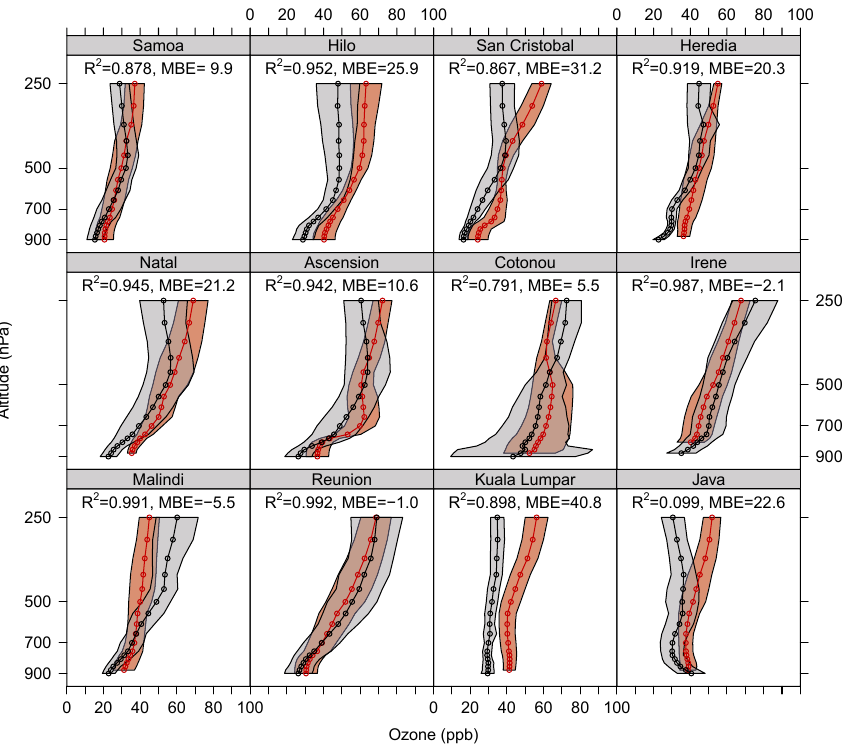
Fig. 3. Five-year mean O 3 (ppb) from the BASE run (red) compared to O 3 sonde data from the SHADOZ Network (Thompson et al., 2003) (ppb) from the BASE run (red) compared to O sonde data from the Fig. 3. Five year mean O 3 3 (black). Polygons show extent of monthly variability. Correlation coefficients ( R 2 ) are calculated using the Pearson method. Mean bias errors (ppb) from the BASE run (red) compared to O sonde data from the Fig. 3. Five year mean O SHADOZ Network (Thompson et al., 2003) (black). Polygons show extent of monthly variability. 3 3 (MBE) are in %; positive values indicate the model is biased high with respect to the measurement data. Correlation coe ffi cients ( R 2 ) are calculated using the Pearson method. Mean bias errors (MBE) SHADOZ Network (Thompson et˜al., 2003) (black). Polygons show extent of monthly variability. are in %; positive values indicate the model is biased high with respect to the measurement Correlation coefficients (R 2 ) are calculated using the Pearson method. Mean bias errors (MBE) Table 2. Changes in the O x budget (Tgyr − 1 ) from the present-day BASE integration caused by the change in various factors between data. present-day and 2095. Also quoted are changes in the O 3 burden (Tg). Percentage changes are in brackets. are in %; positive values indicate the model is biased high with respect to the measurement 36 data.